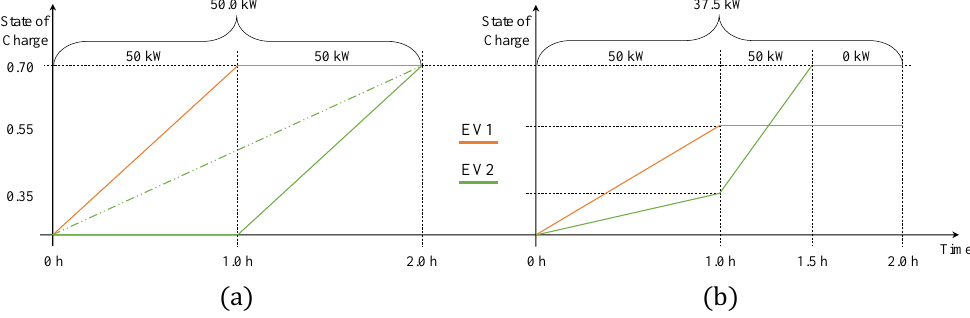
Figure 7. Load Management Strategies. ( a ) Consecutive Charging, ( b ) Simultaneous